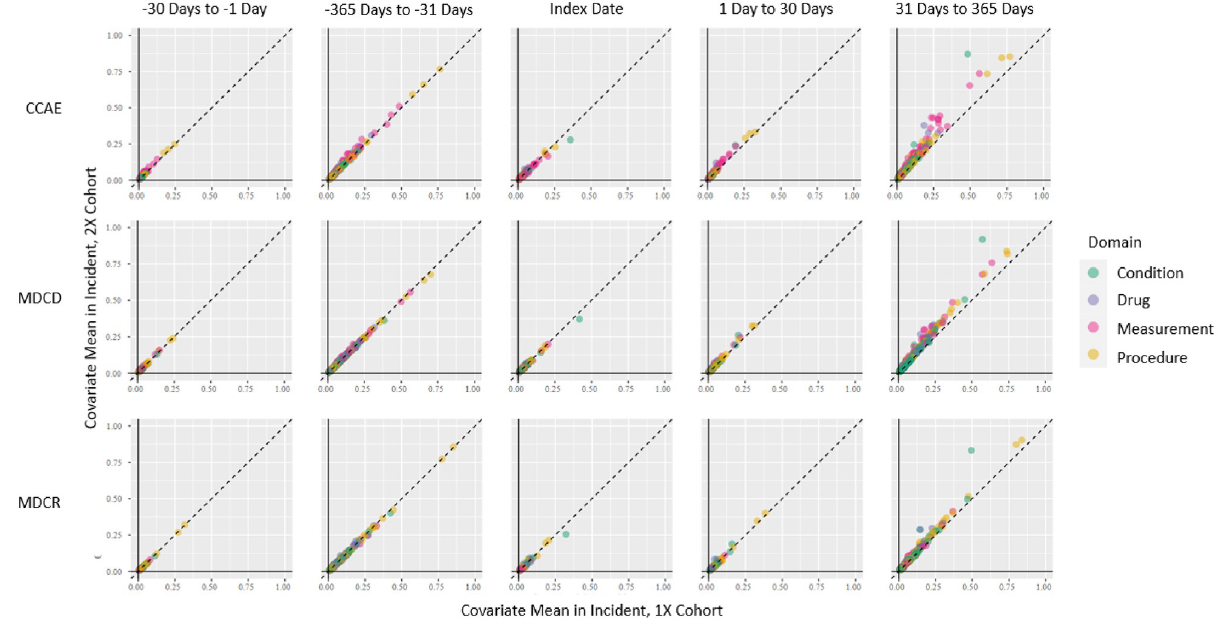
Fig 3. Comparison between proportion of subjects in the “Incident, 1X algorithm” compared to the “Incident, 2X algorithm” for three selected datasets with different demographic characteristics. Points closest to the diagonal indicate similar proportions between the comparators; points farther from the diagonal indicate more disparate